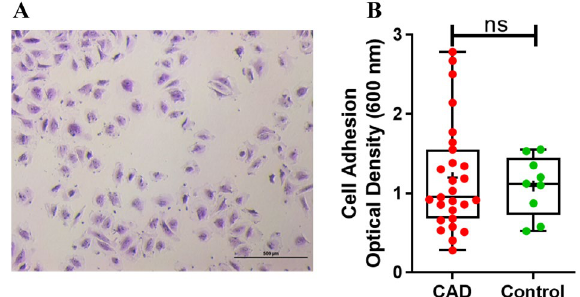
Figure 6. ECFCs adhesion ability in CAD cases and controls. ( A ) Brightfield microscopic image of ECFCs with crystal violet staining for cell adhesion. (10 × magnification; scale bar:500 µm). ( B ) Dot plot represent mean cell adhesion to collagen extracellular matrix in CAD and control groups (n = 27; n = 09). Significance was assessed by Mann–Whitney U test. Data is represented in Box-and-whisker plot with median (IQR), min/ max.; dots represent average values of the parameters obtained from experimental triplicates; p ≤ 0.05 considered statistically significant. ns represent non-significant